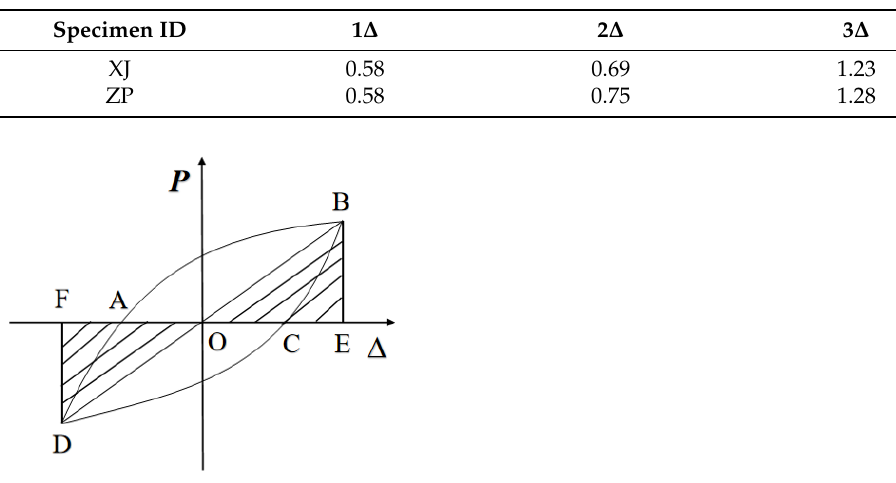
Table 5. Energy dissipation coefficients of specimens XJ and ZP.